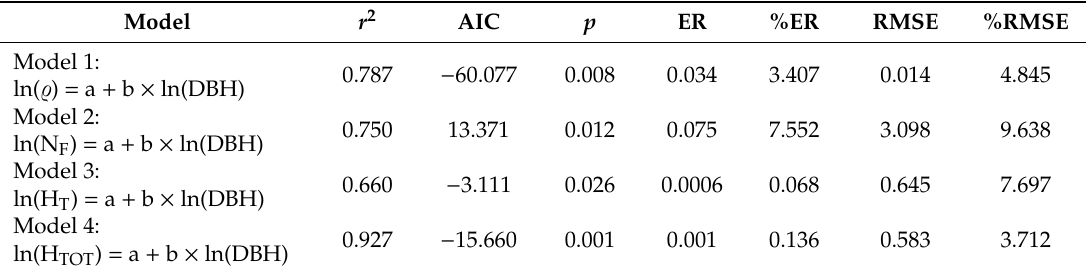
Table 6. Validation of the allometric relationships between the individual explanatory variables ( (cid:37) , H TOT , H T and N F ) and the DBH (for estimates of a and b, see Table 4). Model r 2 AIC p ER %ER RMSE